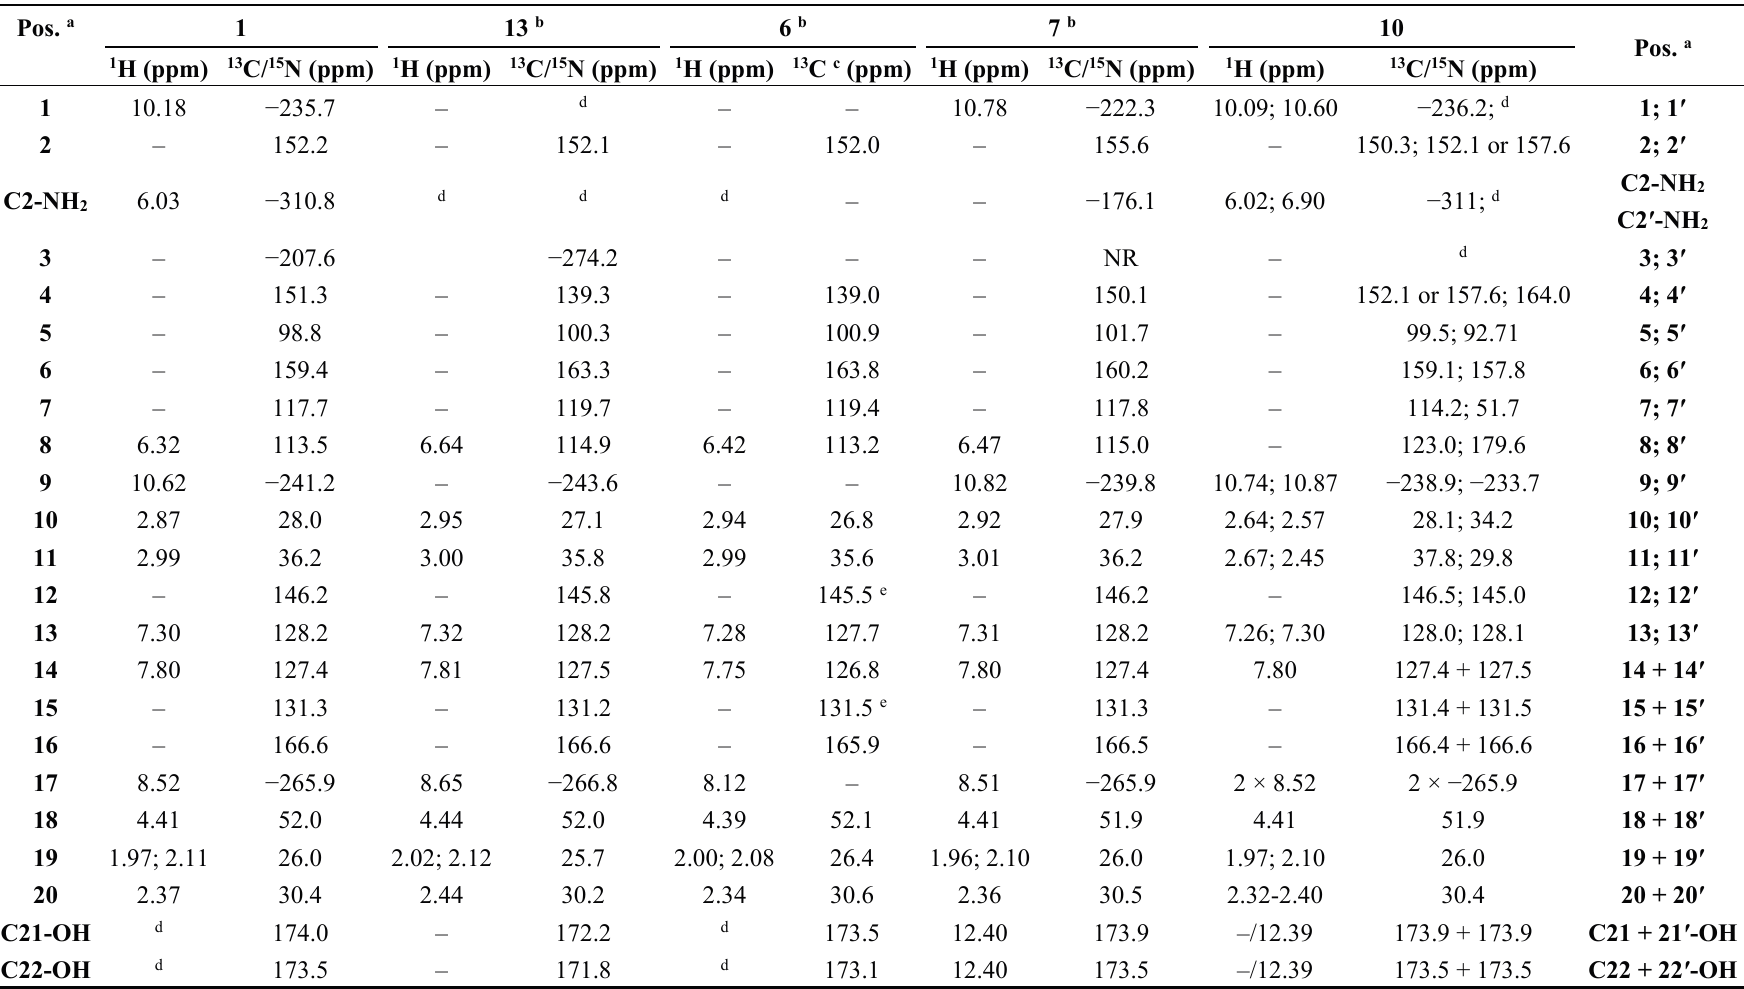
Table 2. Comparison of the NMR data for compounds 1 , 6 , 7 , 10 and 13 with the correlations observed in the HSQC and HMBC spectra. Pos.